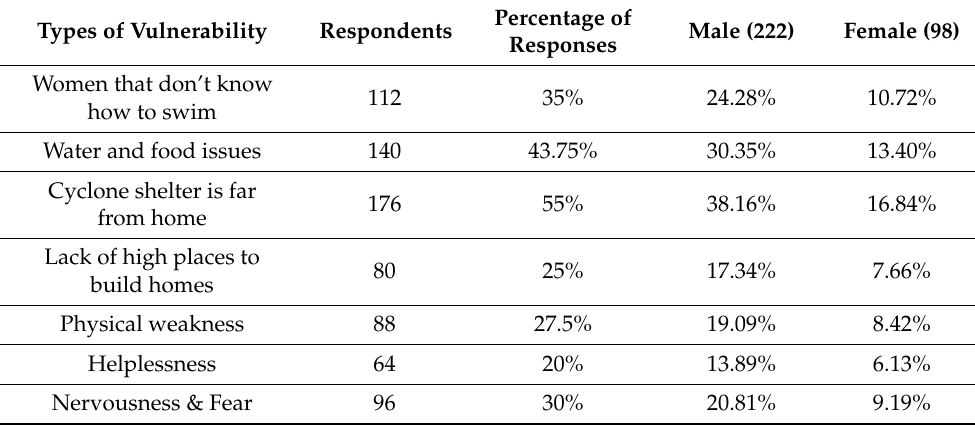
Table 4. Types of vulnerability typically faced by